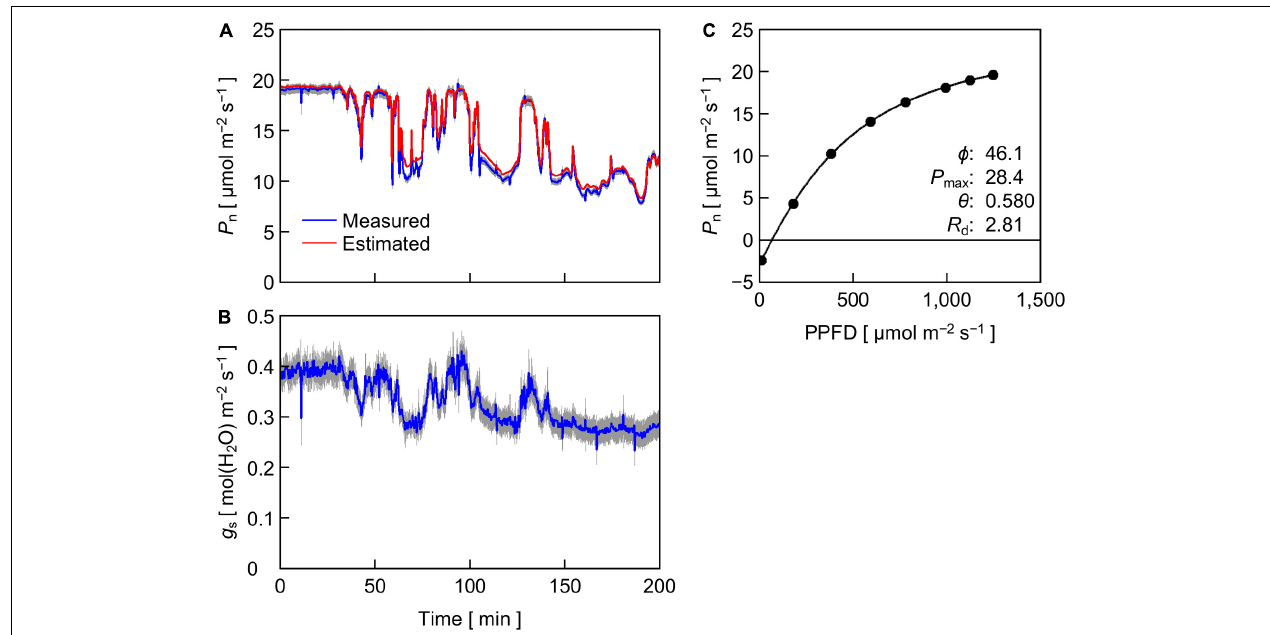
FIGURE 6 | (A,B) Time course of P n (A) and stomatal conductance g s (B) in cucumber leaves measured under reproduced sunlight. For P n , values estimated from the steady-state PPFD-response curve of P n (C) are also shown. The height of gray area at a given time represents the standard errors of the means for the measured values ( n = 12). (C) Steady-state P n in cucumber leaves in response to PPFD. Solid circles are the means of measured values ( n = 12), and the line is a fitting curve with a nonrectangular hyperbolic function, of which parameter values are shown within the panel. Standard errors of the means are smaller than the diameter of the circles and are invisible.